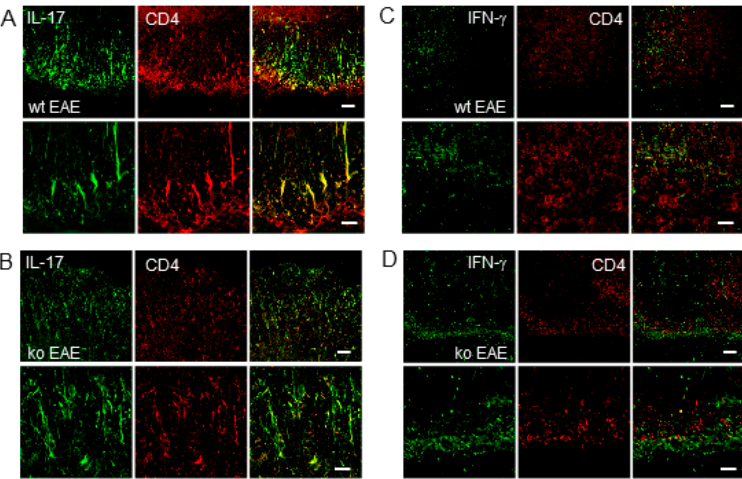
Figure 7. Expression of interleukin-17 (IL-17) and interferon- γ (IFN- γ ) in CD4 + T cells in the spinal cords of EAE mice. Immunohistochemistry image showing IL-17 (green) and CD4 (red) in the inflammatory region of the spinal cords of wt EAE ( A ) and ko EAE ( B ) mice; and IFN- γ (green) and CD4 (red) in the inflammatory region of the spinal cords of wt EAE ( C ) and ko EAE ( D ) mice. Scale bar (50 μ m) for upper panels and (20 μ m) for lower panels of A–D. wt, wild-type; ko, mPGES-1 − / − .